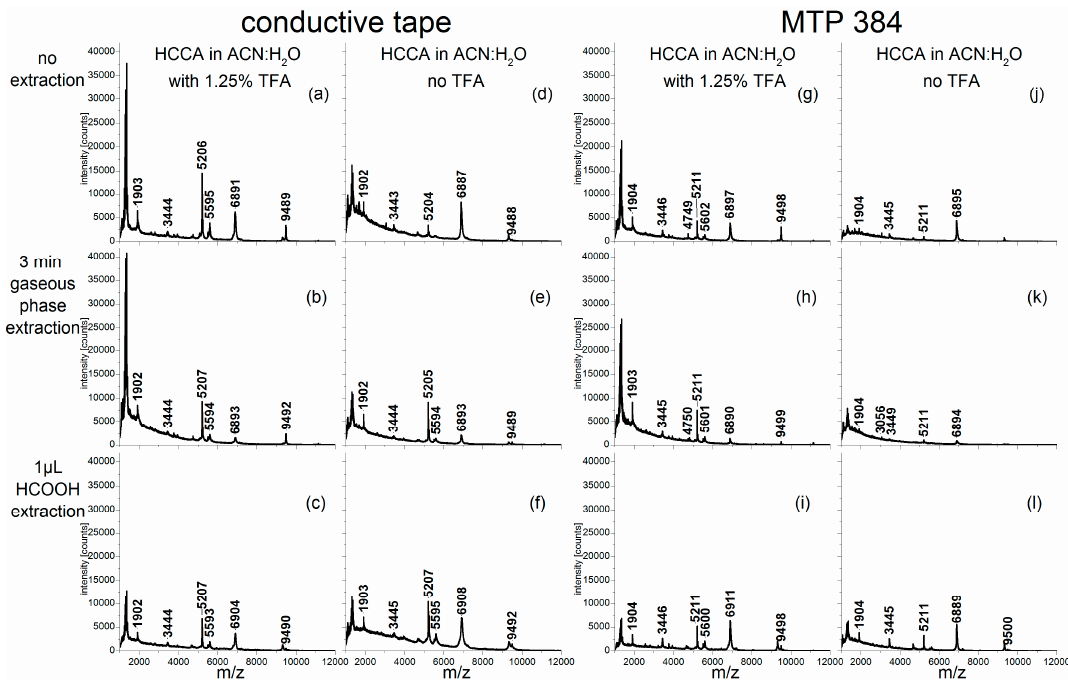
Figure 1. Averaged matrix-assisted laser desorption ionization time of flight (MALDI-TOF) mass spectra ( n = 5) of Alnus cordata pollen grains: measured on conductive tape with trifluoroacetic acid (TFA) in the matrix solution ( a – c ), on conductive tape without TFA in the matrix solution ( d – f ), on the steel target (microtiter plate MTP 384) with TFA in the matrix solution ( g – i ) and on the steel target without TFA in the matrix solution ( j – l ) (in the rows: extraction procedure).